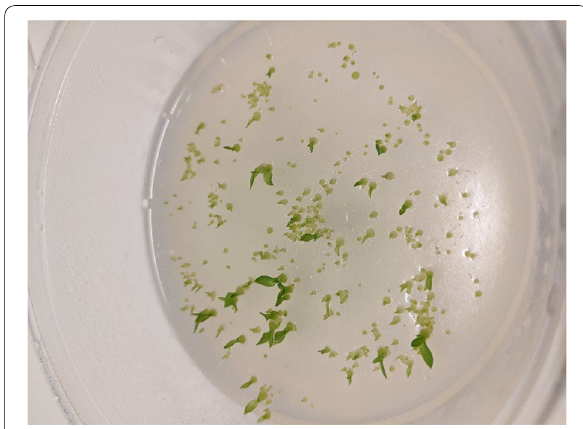
Fig. 5 Seedlings of a Cattleya hybrid in various stages of development in symbiotic in vitro culture with Tulasnella calospora 266 in an 8 oz. polypropylene vessel. Stage 5 seedlings are those with the largest leaves, mostly shown at the left of the image